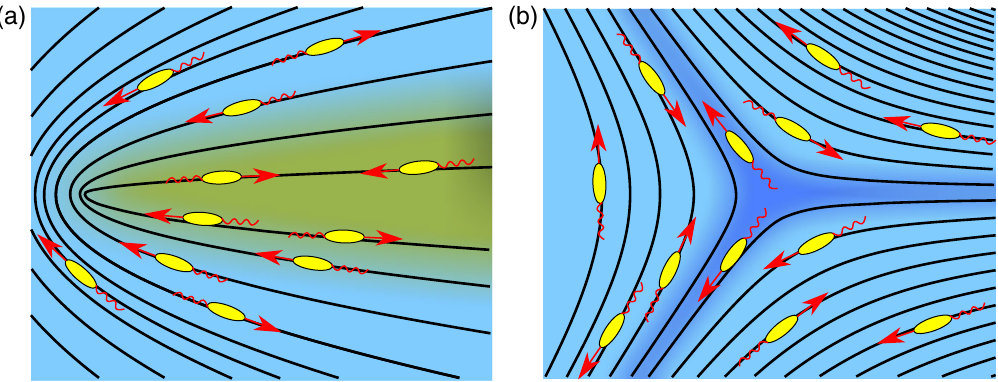
FIG. 6. Illustration of accumulation and depletion of bacteria in topological defects. (a) Accumulation of bacteria in þ 1 = 2 defect. Bacteria accumulate in the yellow region due to the convergence of bacterial trajectories. (b) Bacteria escape from the dark blue region of − 1 = 2 defect independently of their initial